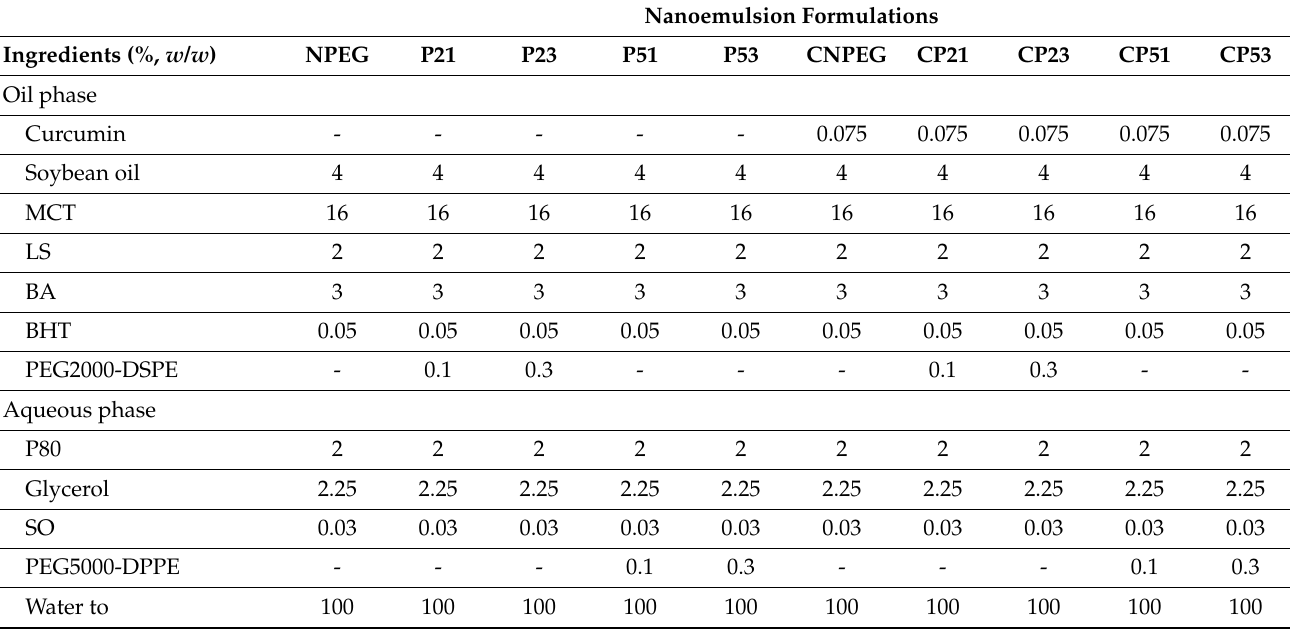
Table 3. Composition of placebo and curcumin-loaded nanoemulsions.